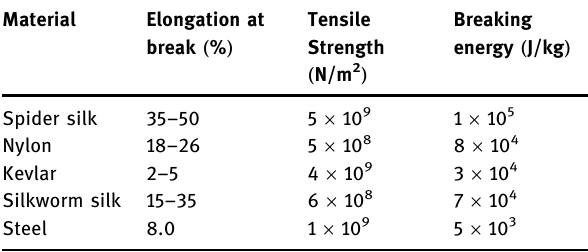
Table 1: Comparison of the mechanical properties of spider silk